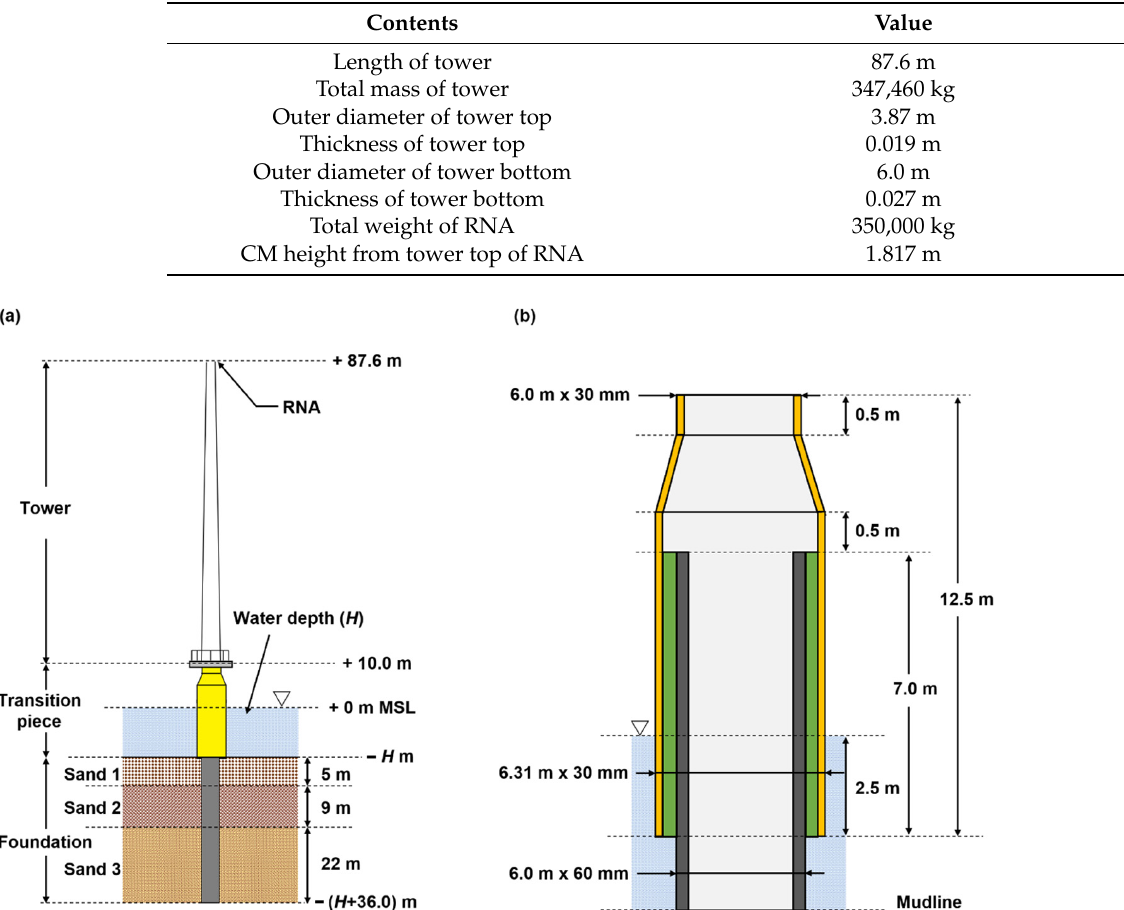
Table 1. Specification of turbine model of NREL 5 MW reference wind turbine [35].